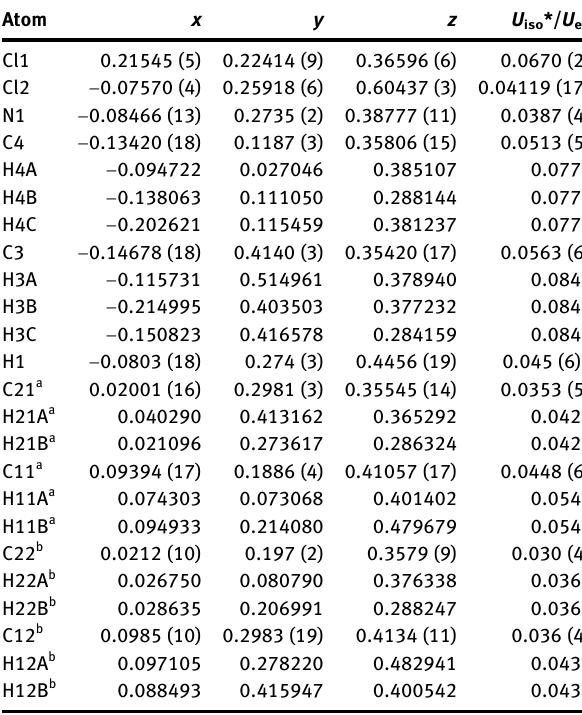
Table  : Fractional atomic coordinates and isotropic or equivalent isotropic displacement parameters (Å 